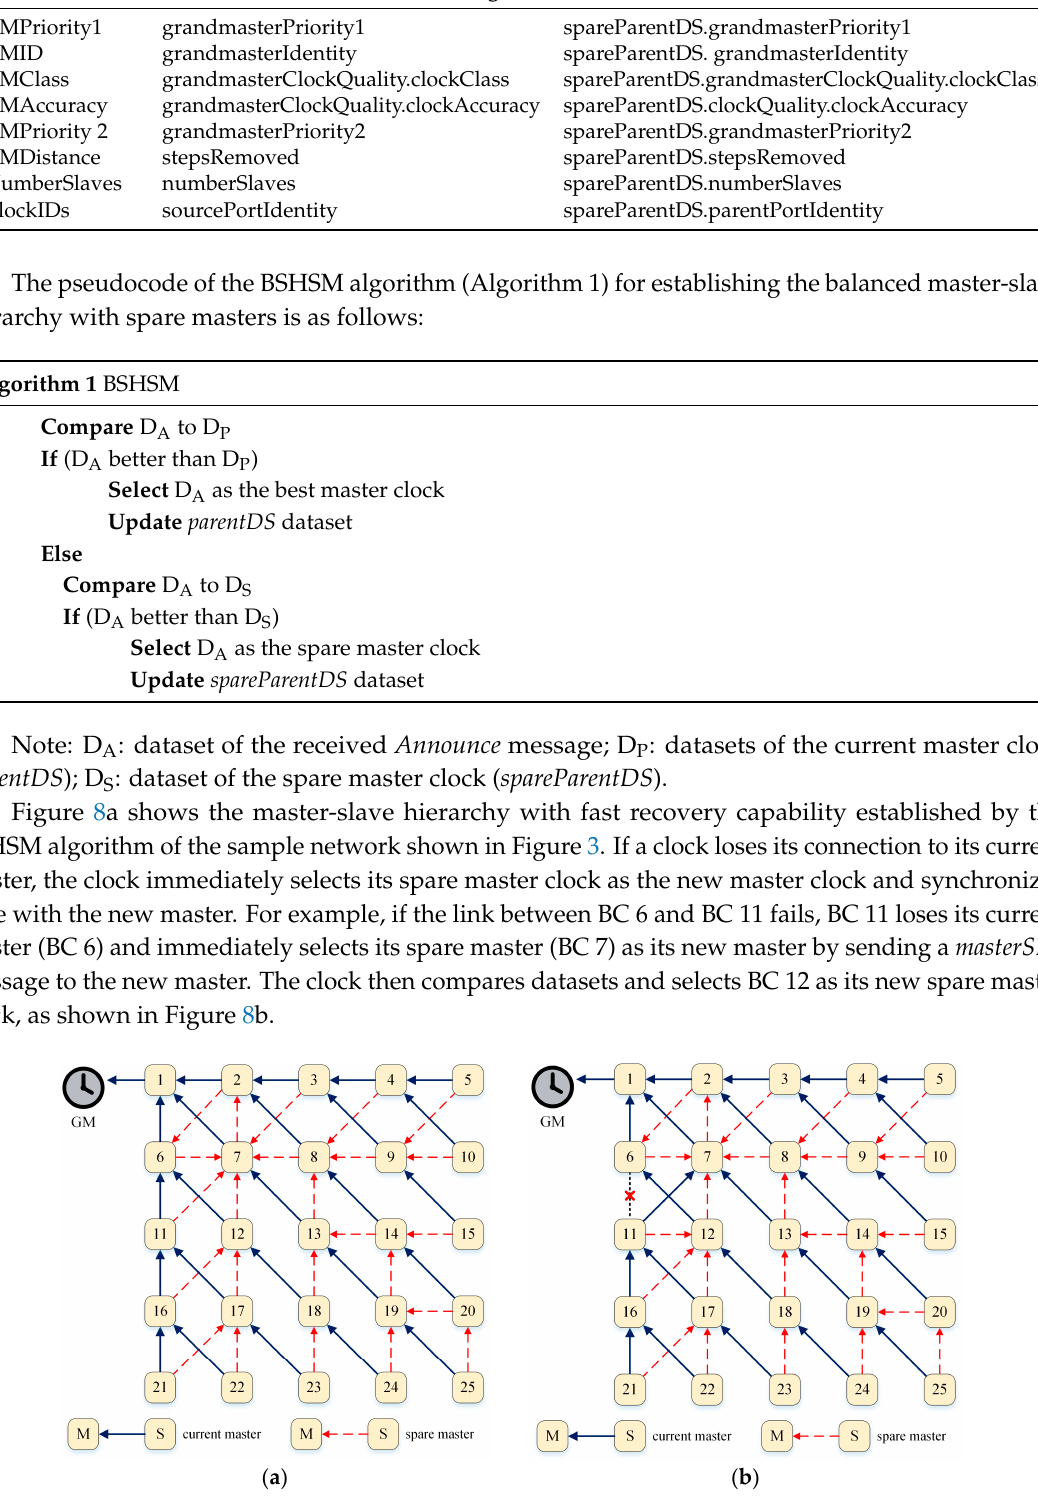
Figure 8. The master-slave hierarchy with spare masters established by the BSHSM algorithm. ( a ) In the failure-free case; and ( b ) in the failure case.